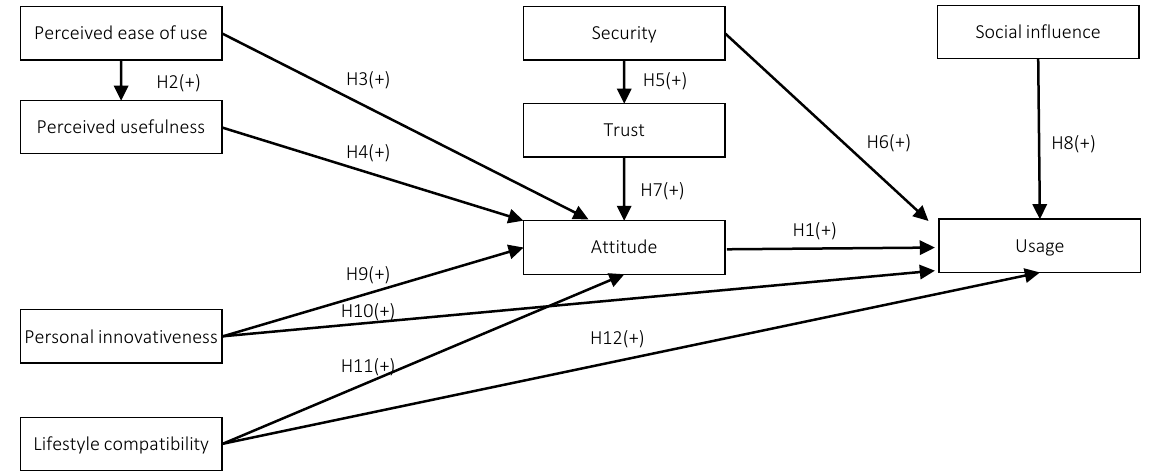
Figure 1. Research model